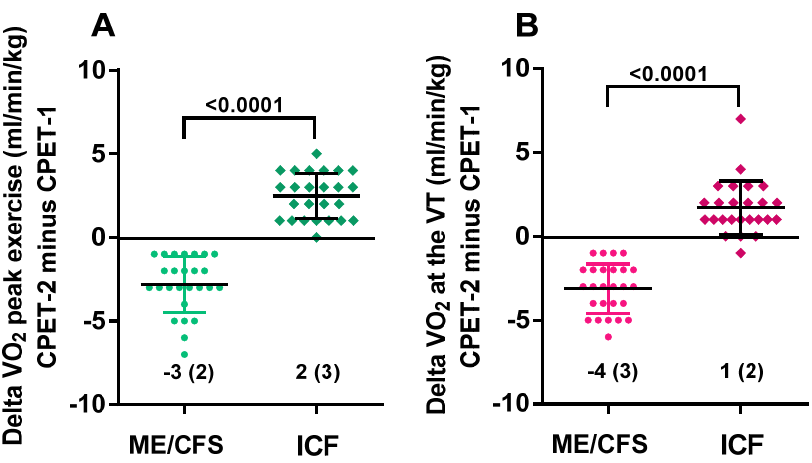
Figure 2. The range of absolute differences for peak VO 2 ( A ) and VO 2 at the ventilatory threshold ( B ) for ME/CFS and ICF patients. Legend Figure 2: CPET: cardiopulmonary exercise test; ME/CFS: myalgic encephalomyelitis/chronic fatigue syndrome; ICF: idiopathic chronic fatigue; VO 2 : oxygen consumption; VT: ventilatory threshold.